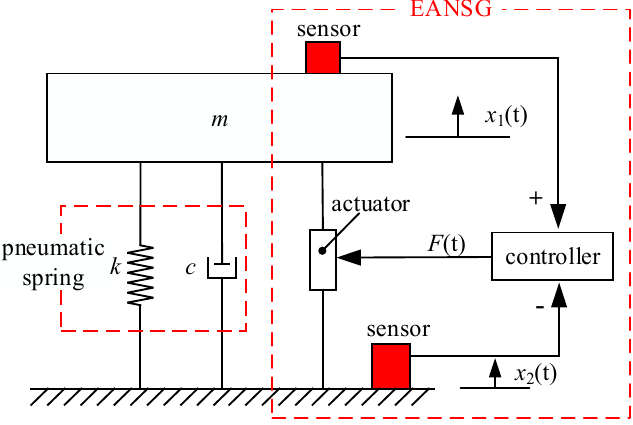
Figure 13. Bandwidth test curve of the amplifier.